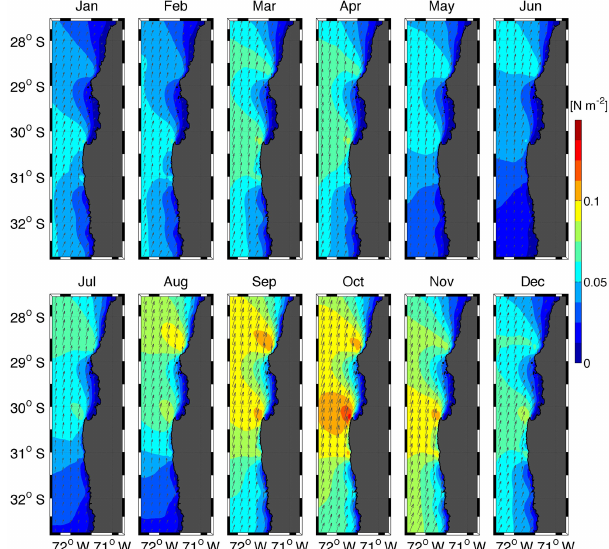
Figure 5. Annual cycle of Ekman pumping (vertical velocity in md − 1 ) obtained from the simulation at 4km resolution (for 2007–